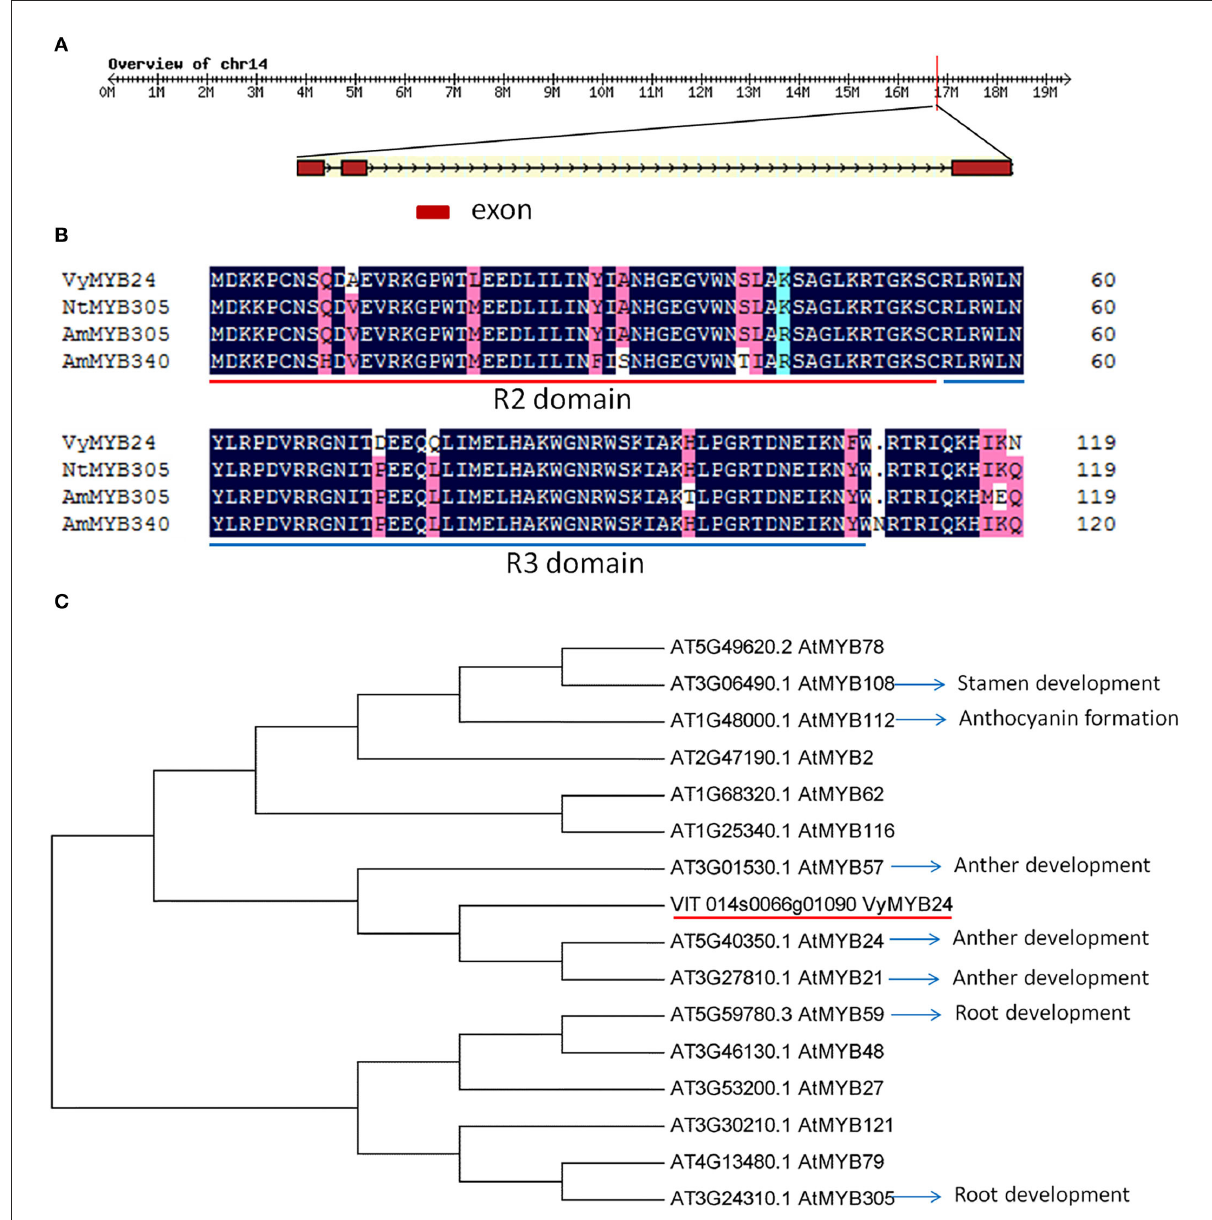
FIGURE1 Features of VyMYB24 protein. (A) The genomic sequence of VyMYB24 . (B) Alignment of VyMYB24 protein with other R2R3-MYB proteins from N. tabacum and A. majus . R2 and R3 are the two repeats of the MYB DNA-binding domain. GeneBank accession numbers are as follows: NtMYB305 (XP_016506729), AmMYB305 (P81391), and AmMYB340 (P81396). (C) Phylogenetic analysis of VyMYB24 protein with other 15 R2R3-MYB proteins from Arabidopsis . The phylogenetic tree was generated using the neighbor-joining method by MEGA5.0. Part of the R2R3-MYB genes was involved in plant